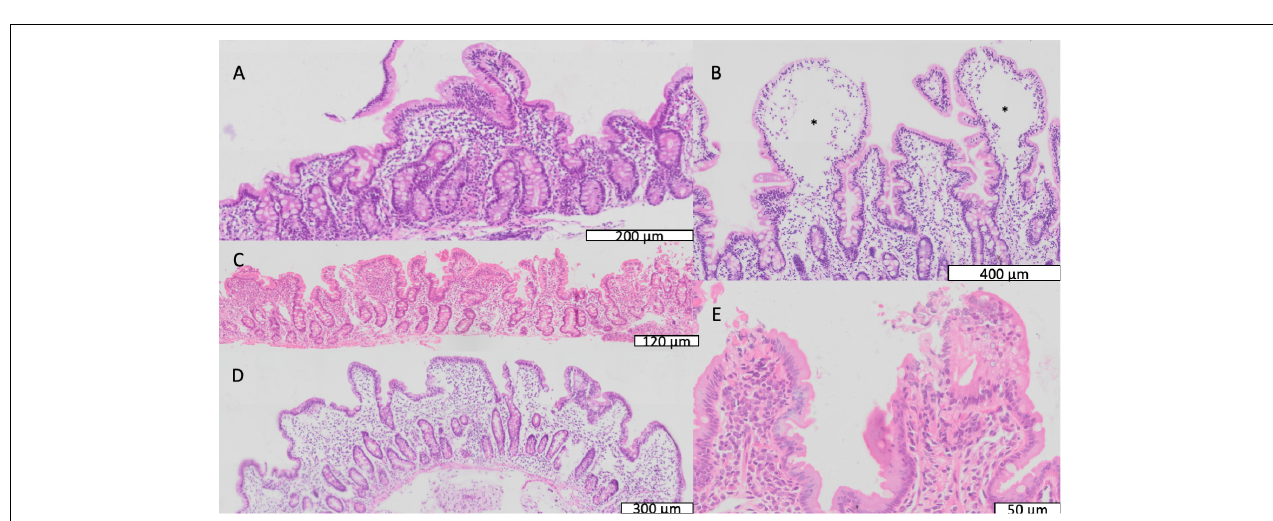
FIGURE 2 | Mucosal features of environmental enteropathy. (A) Marked villus blunting in a well-orientated section (confirmed by crypts imaged in full longitudinal section). (B) Ballooning of villus tips caused by expansion of translucent material or oedema marked by *. (C) Pronounced inflammatory infiltrate in lamina propria. (D) Extensive villus fusion, in which fused villus structures overlie several crypts. (E) Loss of epithelial integrity at villus tips representing microerosions.